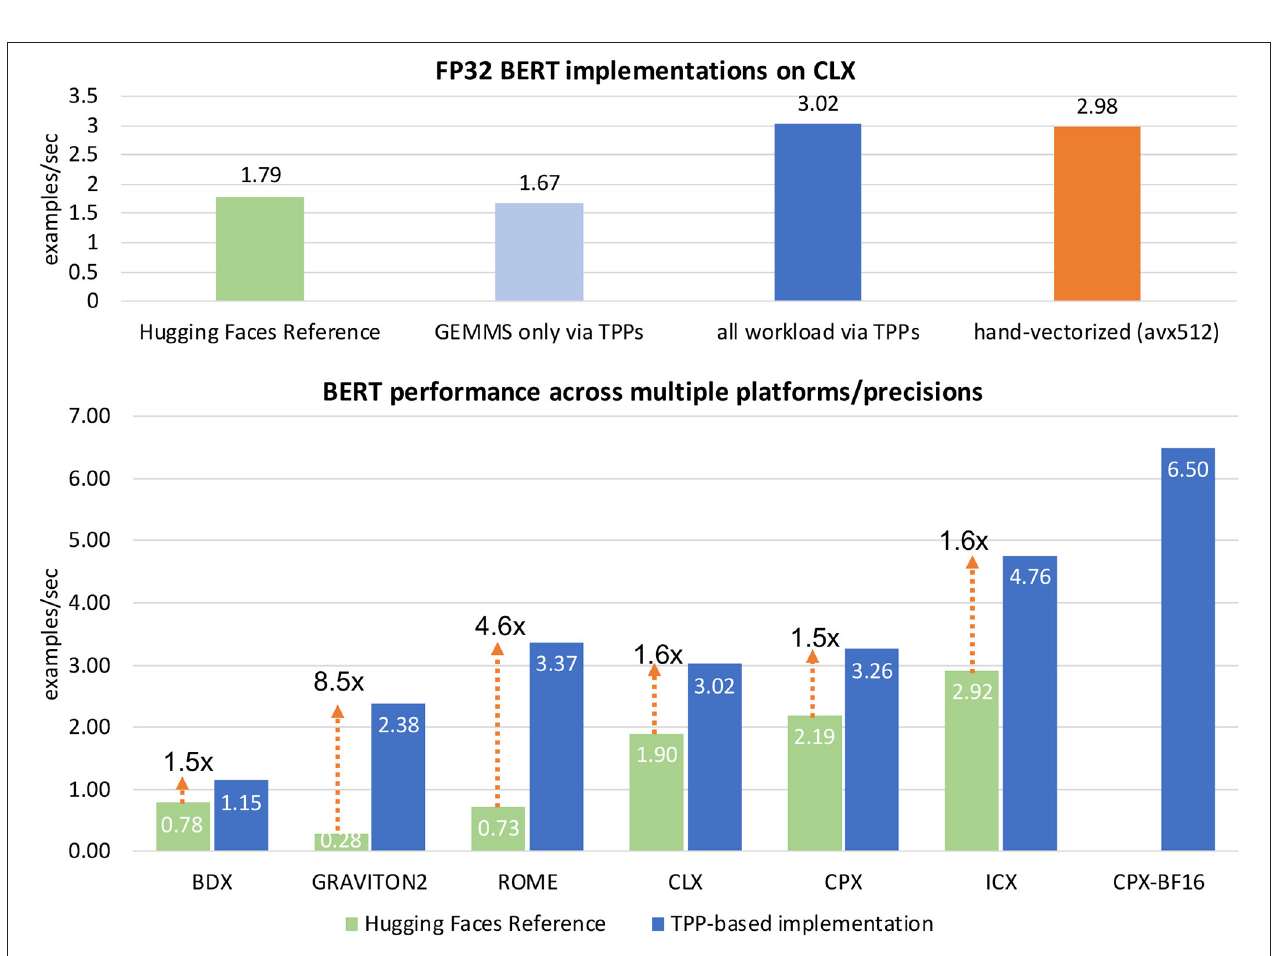
FIGURE 25 | BERT large